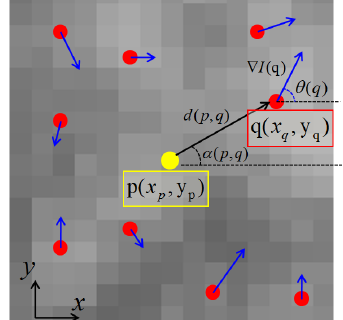
Figure 2. Geometric and gradient information from a local maximum (resp. local minimum) pixel ( p ) (resp. N min ( p ) ) considered for the calculation of LED descriptor at the q = ( x q , y q ) within N max W W studied keypoint p = ( x p , y p ) . Here, d ( p , q ) is the distance between p and q ; α ( p , q ) is the angle of the vector yielded from p to q . We have d ( p , q ) = d ( q , p ) but α ( p , q ) (cid:54) = α ( q , p ) . Then, ∇ I ( q ) , θ ( q ) are the gradient magnitude and gradient orientation at q